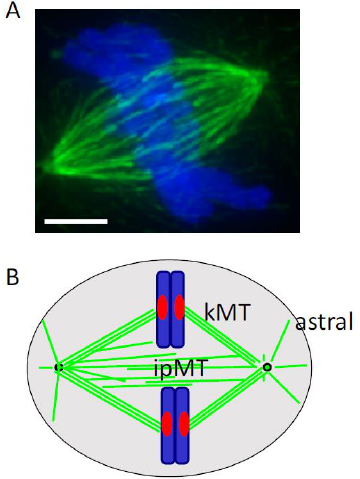
Figure 1. The metaphase spindle. ( A ) Overlay shows tubulin (green) and DNA (blue) in a mammalian cell. The cell was fixed and processed for immunofluorescence. Scale bar, 5 μm; ( B ) Schematic highlights kinetochore (kMT), interpolar (ipMT), and astral microtubules. DNA: blue; kinetochore: red; tubulin: green; centrosome: black circle.